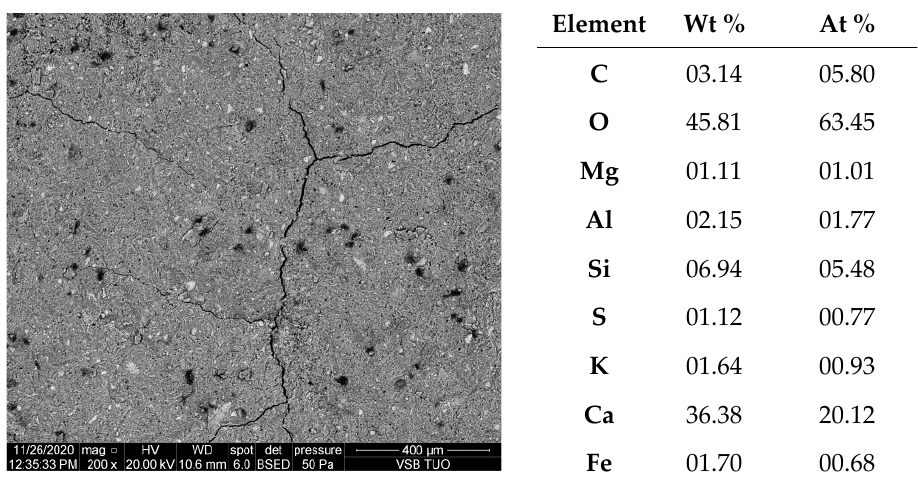
Figure 3. SEM images of the microareas of C.I.3 specimen: ( a ) Needle-like crystals of ettringite; ( b ) Platty crystals of portlandite.